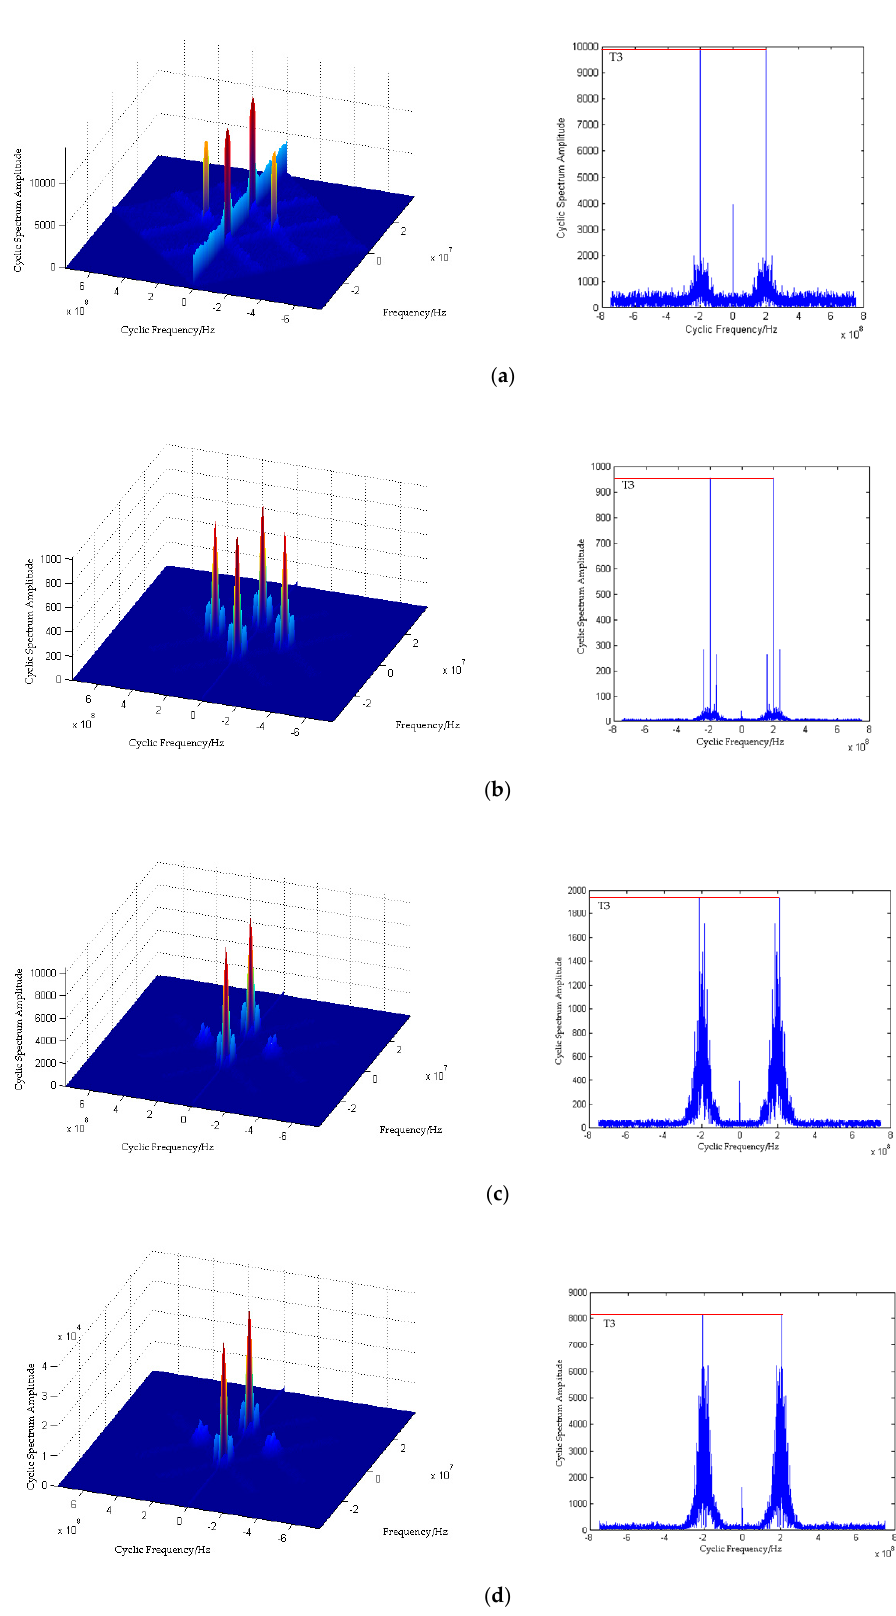
Figure4. Cyclicspectrumand cross-sectional diagramsof( a )OOK (on-o ff keying), ( b )DPSK (di ff erential phase shift keying), ( c ) 16QAM (16 quadrature amplitude modulation) and ( d ) 64QAM (64 quadrature amplitude